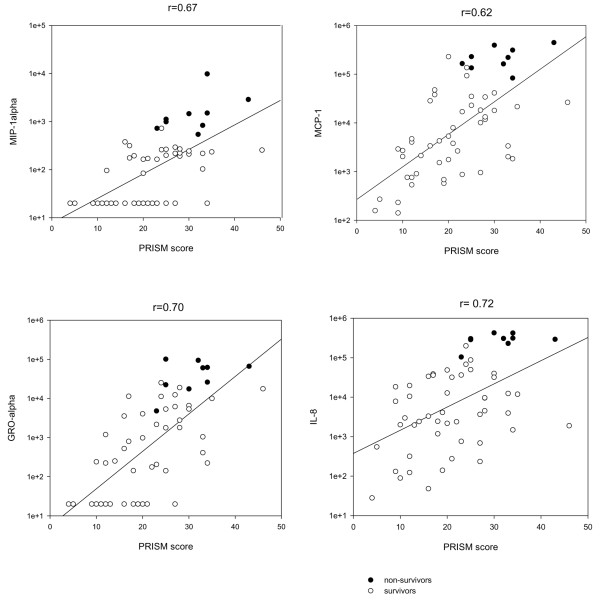
Correlation between chemokine levels in serum samples of children with meningococcal sepsis or septic shock and Pediatric Risk of Mortality (PRISM) scores on admission. The horizontal lines in the charts for macrophage inflammatory protein 1α (MIP-1α) and growth-related gene product alpha (GRO-α) indicate the detection limit for the assay. MCP-1, monocyte chemoattractant protein 1.